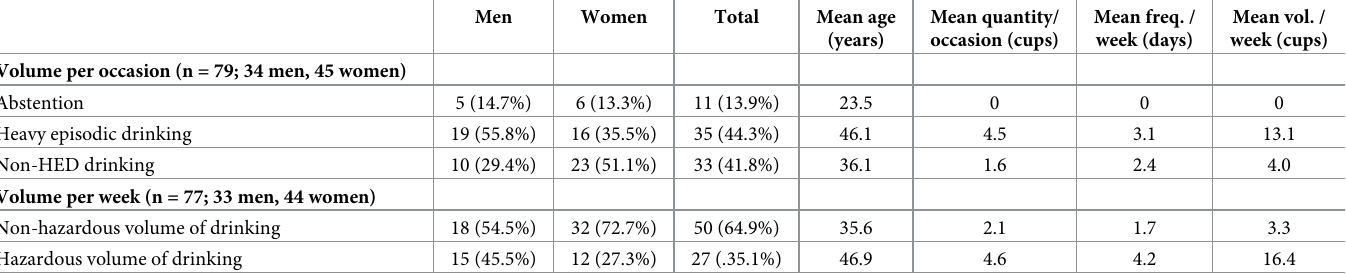
Table 3. Estimated sample prevalence of different drinking behaviours, using WHO definitions and a conservative estimate of average 29.4% ABV in Mbendjele